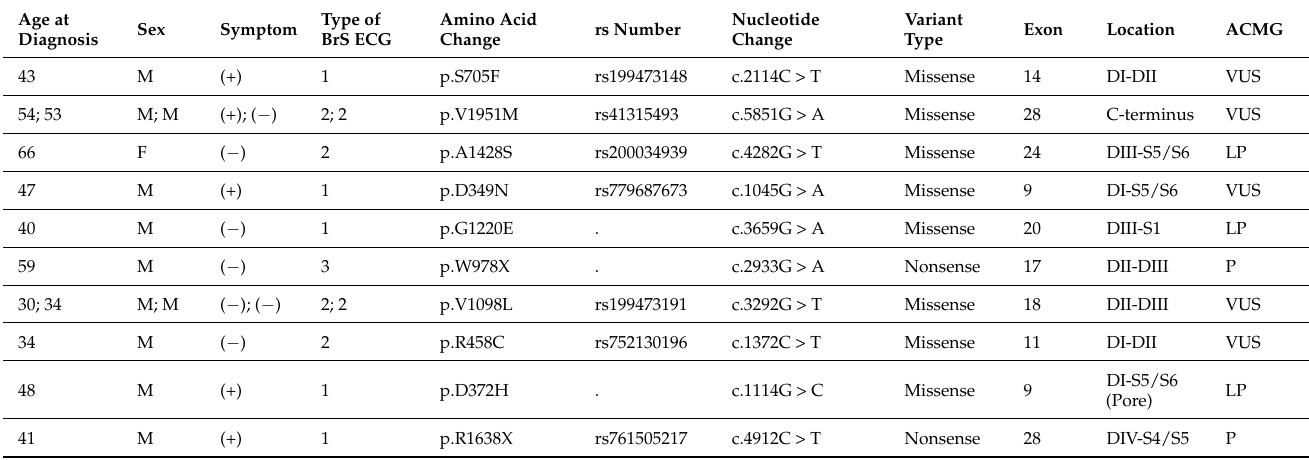
Figure 2. Waterfall plot and needle plot of the variants in genes associated with BrS. ( A ) A summary waterfall plot of variants in BrS-susceptibility genes. Each column represents 1 of the individuals, and each row represents a gene. The bar plot on the top shows the number of variants in each individual. The bar plot on the right shows the number of individuals containing a variant in each gene. ( B ) The variants needle plot of the SCN5A at the protein level across the BrS patients. A premature stop is symbolized by a black circle, whereas a green circle denotes an altered amino acid. BrS = Brugada syndrome; ECG = electrocardiogram; P/LP = patients with pathogenic or likely pathogenic mutations; and VUS = patients with uncertain significance variants. Table 2. Clinical and genetic characteristics of SCN5A variant